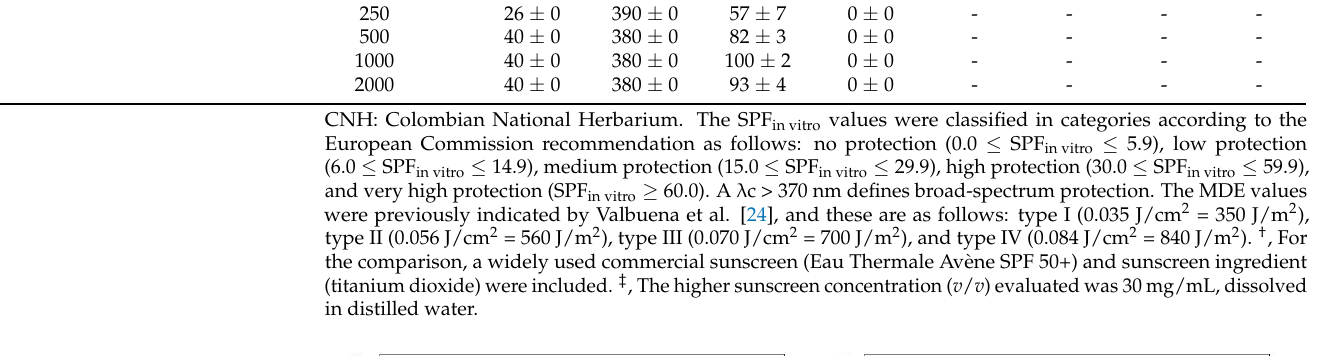
Species (CNH Voucher)